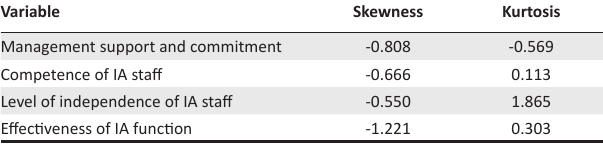
TABLE 2: An analysis of the skewness and kurtosis values of the variables.